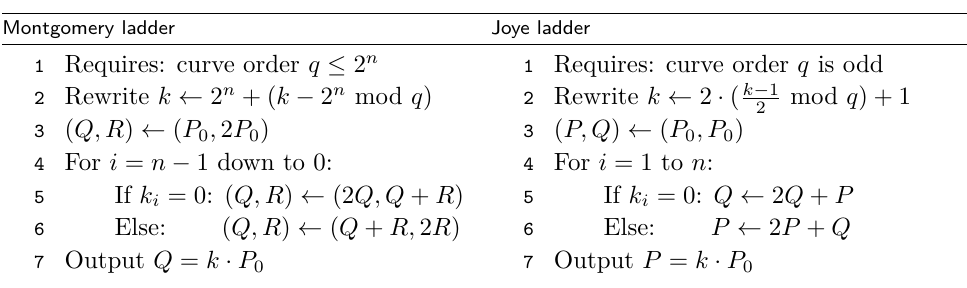
Figure 1: The Montgomery and Joye ladders, modified for nonzero initial state. Montgomery form y 2 = x 3 + Ax 2 +